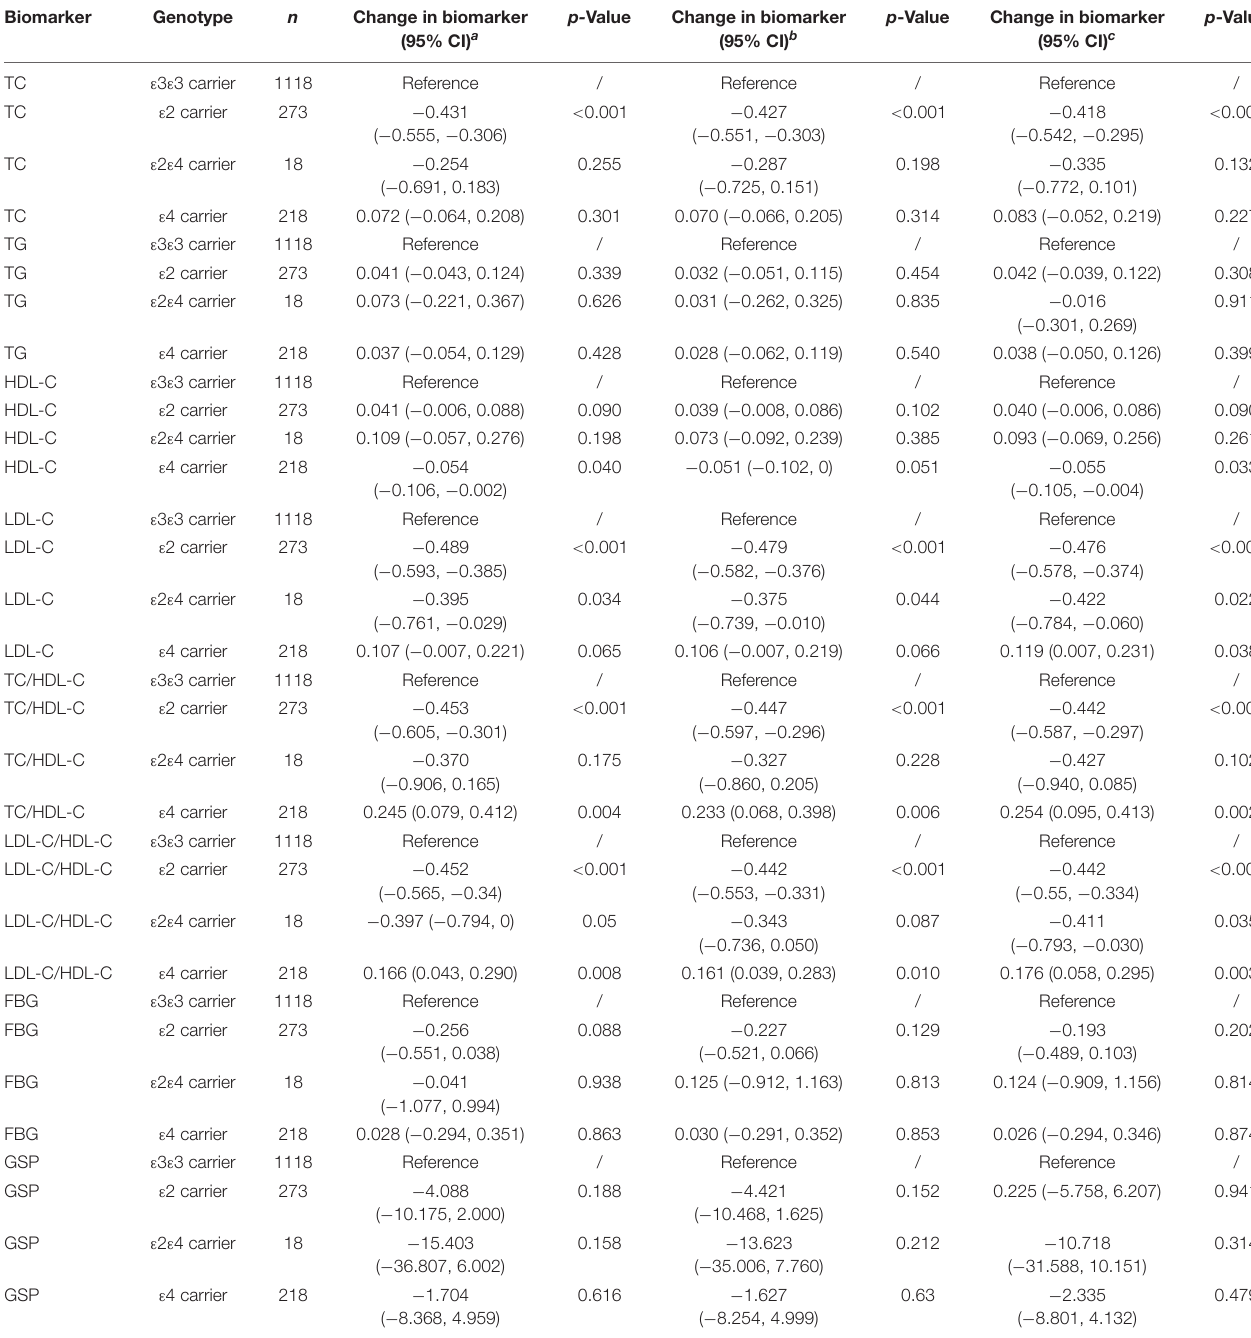
TABLE 2 | Differences of lipids and glucose level by APOE